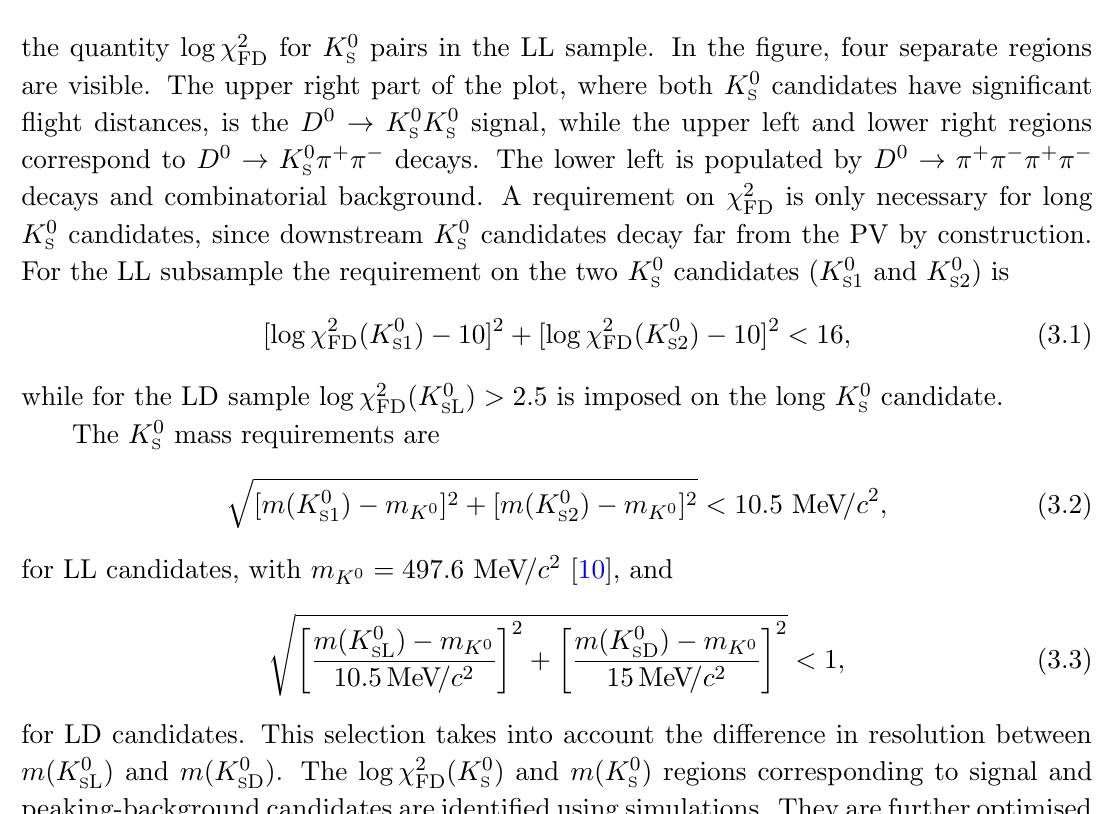
Figure 2 . Two-dimensional distribution of the logarithm of the K 0 (log (cid:31) 2 ) for the two K 0 candidates in the LL subsample of D 0 ! K 0 FD S signal can be observed in the upper right region of the plot. The contour corresponds to eq. (3.1).